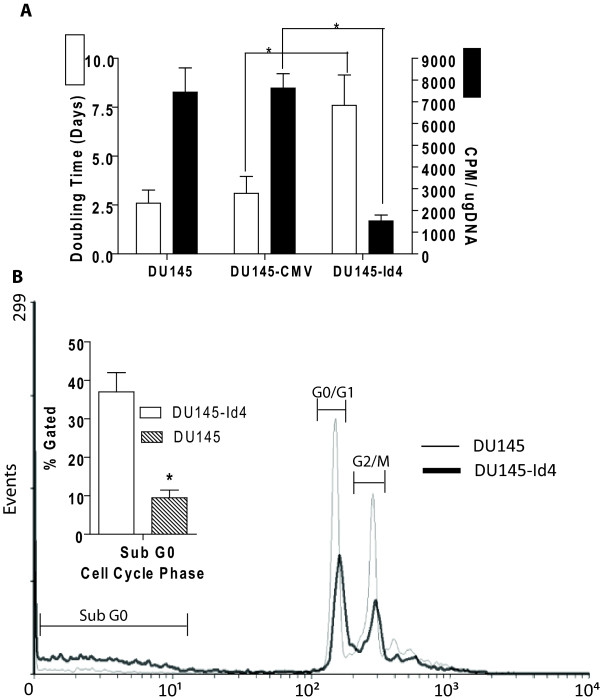
(A): Doubling time (in days, White bars) and rate of proliferation (Black bars) of DU145, DU145-CMV and DU145-Id4 cells line in culture. All the cell lines have matched passages. The DU145 cells were either transfected with no plasmid (DU145), CMV vector alone (DU145-CMV/EV) or pCMV-Id4 (DU145-Id4). White Bars: The average doubling time of DU145-Id4 cells as compared to DU145 and DU145-CMV. The data is an average cell count from four passages. The doubling time was calculated by counting days required for the number of plated cells (usually at 40% confluence) to reach confluence (80%). For DU145-Id4 cells, this average is from passage 13–16. A highly significant increase in the doubling time (approximately 2.5 fold) (P < 0.001) suggests that Id4 over-expression leads to a decrease in proliferation. Black Bars: 3H thymidine incorporation assay. 3H thymidine incorporation (CPM) was evaluated as a measure of rate of proliferation. The counts per minute (CPM) of incorporated 3H-thymidine was normalized to total DNA. The data represents CPM/ug DNA of cell lines at passages 14 and 15. The data is represented as mean ± SEM of three experiments performed in triplicates. *: P < 0.001. (B) FACS analysis of cell cycle parameters in DU145 and DU145-Id4 cell lines. The cell cycle profile showing fraction of cells in each phase of the cell cycle in DU145-Id4 and DU145 cells is shown. The data is representative of at least three experiments. The inset shows the fraction of cells in sub-G0 phase (normalized to 10,000 cells). The cells in sub-G0 phase have low DNA content possibly due to apoptosis. The mean ± SEM of three experiments performed in triplicate is shown (*: P < 0.001).